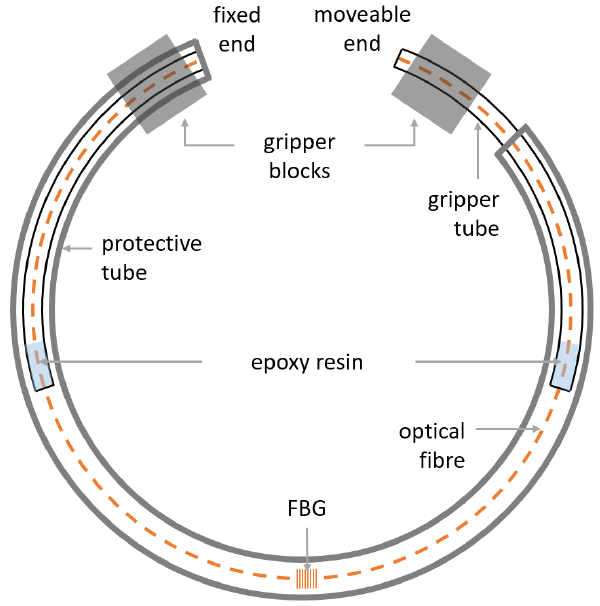
Figure 7. Schematic diagram of an FBG hoop-strain sensor described in